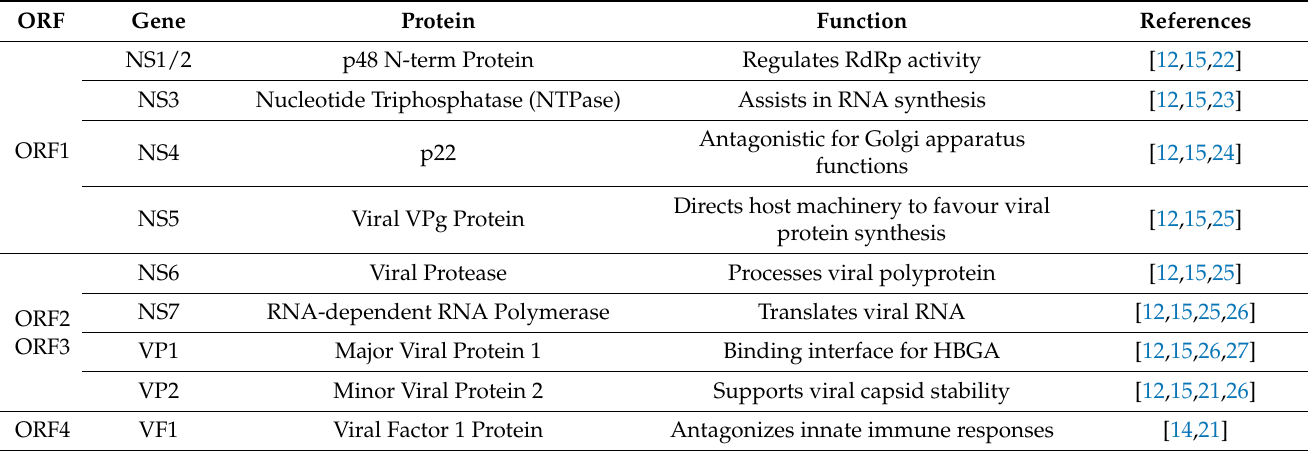
Table 1. NoV Open reading frames, genes and proteins associated with viral survival and